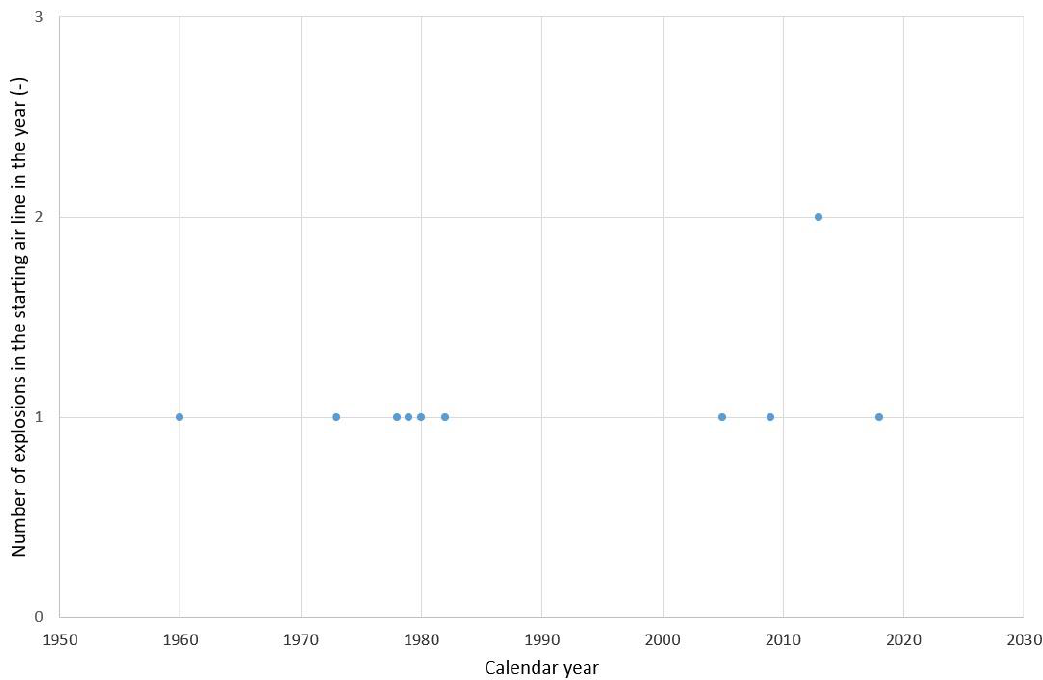
Figure 2. Annual distribution for the number of explosions in the starting air manifold, determined from events extracted from the literature search on the topic (own research ) .